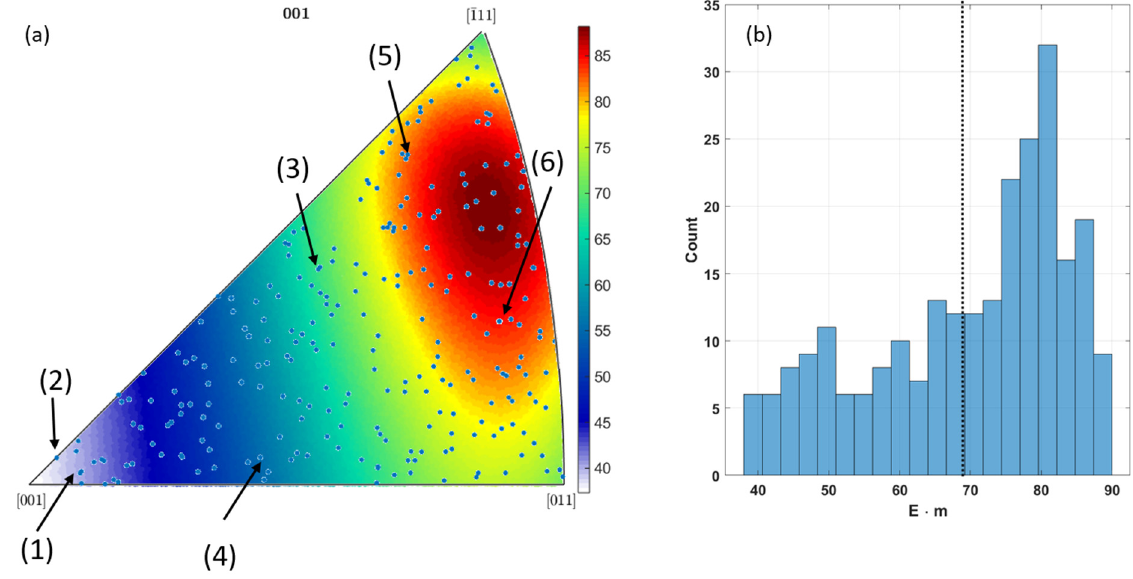
Figure 11. Distribution of random orientations in the inverse E · m plot ( a ) and its histogram ( b ). It can be clearly seen at the inverse pole plot that the orientations are randomly dis- (b)). The histogram also shows a shift of the distribution to higher 𝐸 ∙ 𝑚 values, which